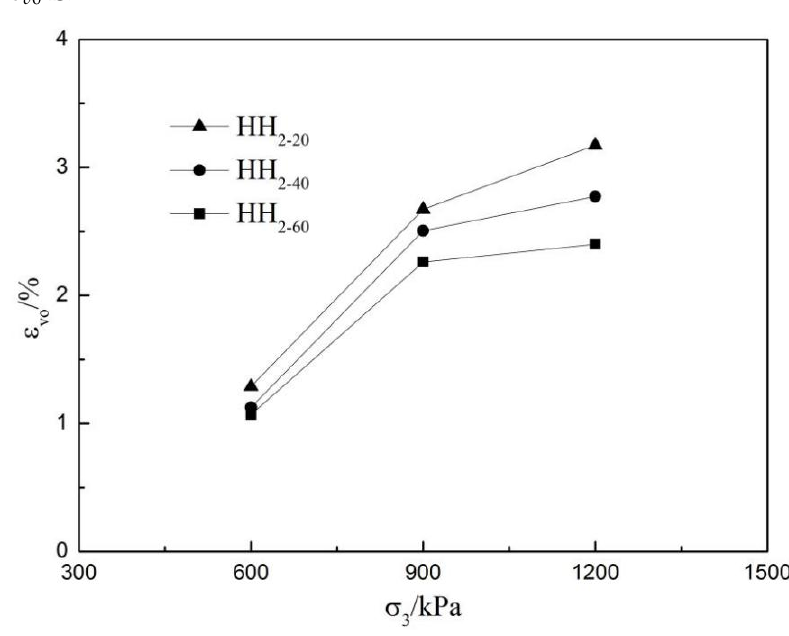
ε and confining pressure 3